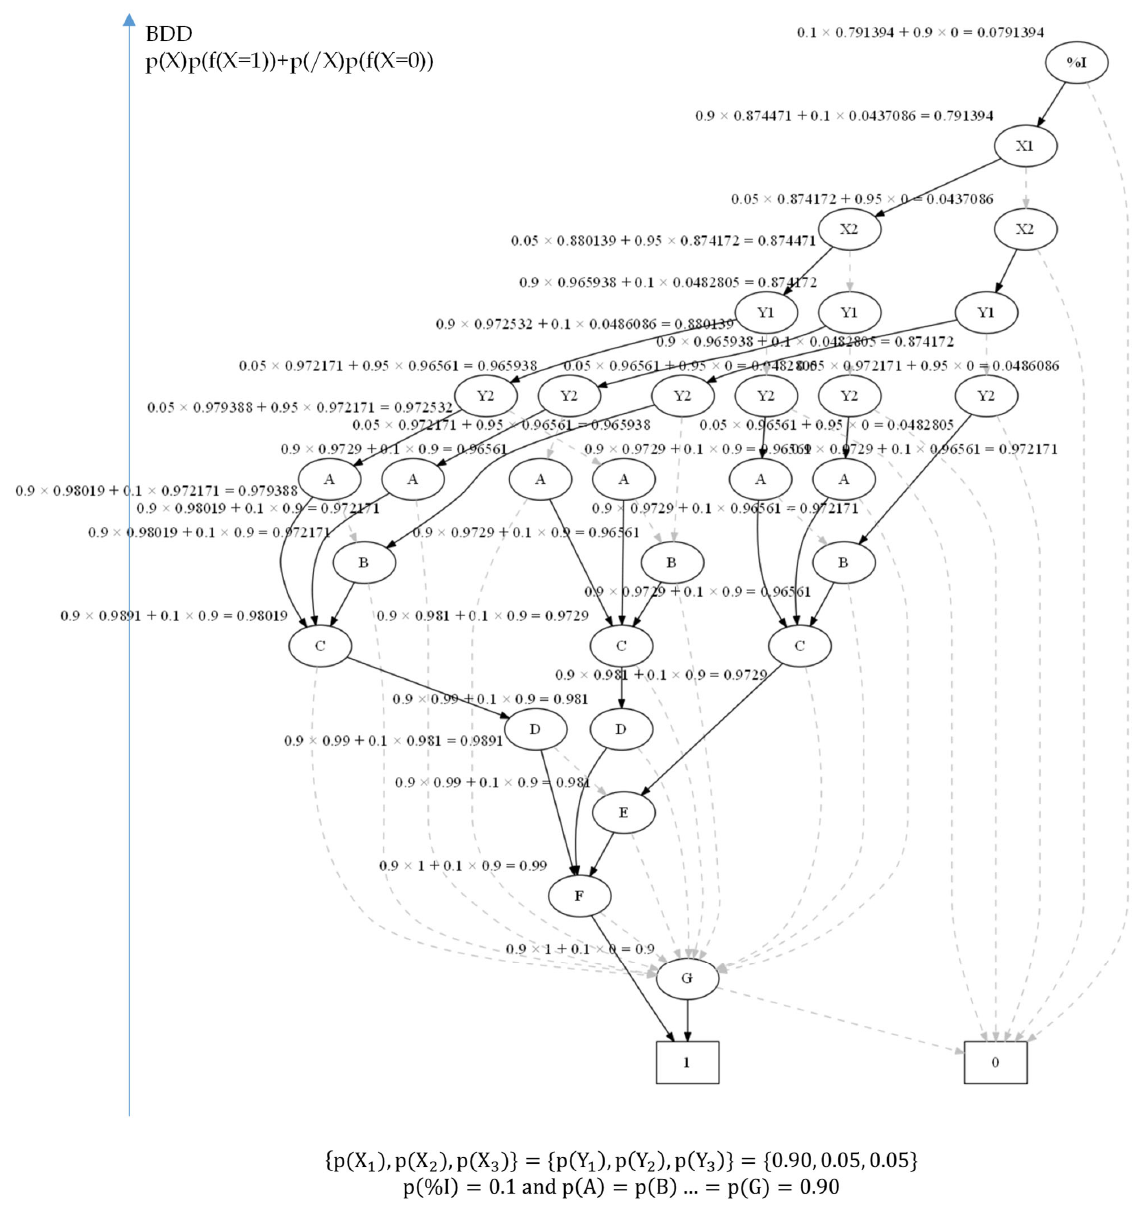
Figure 5. BDD for MUCDF with partitioning events.